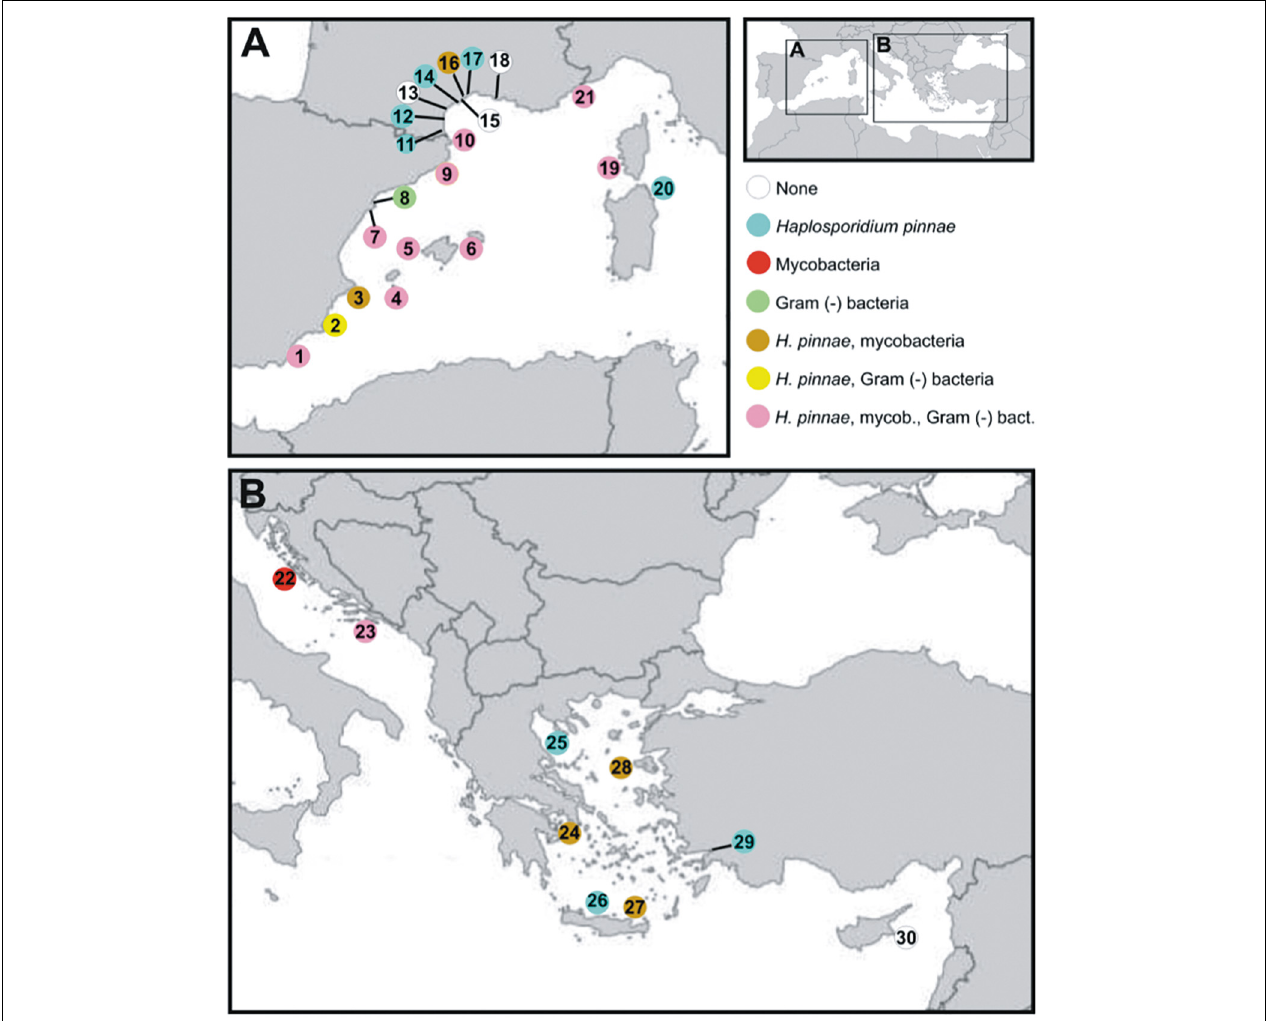
FIGURE 1 | Map of the Mediterranean Sea showing sampling locations. Next is the list of sampling locations with indication of the ecosystem type (H: harbour; L: coastal lagoon; S: open sea). (A) Spain: El Calón, S (1); Mar Menor, including Isla Barón, L, Isla Perdiguera, L, and Pinna Point, L (2); Calpe, including Calpe, S, and Villajoyosa, H (3); Cabrera, including Castell de Cabrera, S, and Santa María, S (4); Majorca, including Andratx, S and Magaluf, S (5); Minorca, including Son Saura, S, Boya Rey, Cala Gandulf, S, and Rates, S (6); Delta de l’Ebre-Alfacs, L (7); Delta de l’Ebre-Fangar, L (8); Tossa de Mar, S (9); Portlligat, S (10). France: Agde, including Agde, S, and Port Ambonne, H (11); Étang de Salses, including Port Leucate, H, Leucate Nord, L, Leucate Centre, L, Leucate Sud, L, and Lido Port-Leucate, H, (12); Étang de Thau, including Grau des Quilles, L, Marseillan Plage, L, and Meze, L (13), Port de Frontignan, H (14); Port La Nouvelle, H (15); Port Saint Louis du Rhone, L (16); Port Vendres, including Plage de Peyrefite, S, and Port Vendres, H (17); Port-Sète, H (18); Ajaccio, S (19). Italy: Tavolara, S (20). Monaco: Monaco, S (21). (B) Croatia: Telaš´cica, S (22); Elaphiti, S (23). Greece: Atica-Euboean Gulf, including Lavrio, S, Avilda, S, and Oropos, S (24); Halkidiki, S (25); Crete-Bali, S (26); Crete-Elounda, S (27); Lesvos, S (28). Turkey: Karaka Beach, S (29). Cyprus: Protaras, S (30). Colours of the circles correspond to the pathogens [ Haplosporidium pinnae , mycobacteria or Gram ( − ) bacteria] detected in each